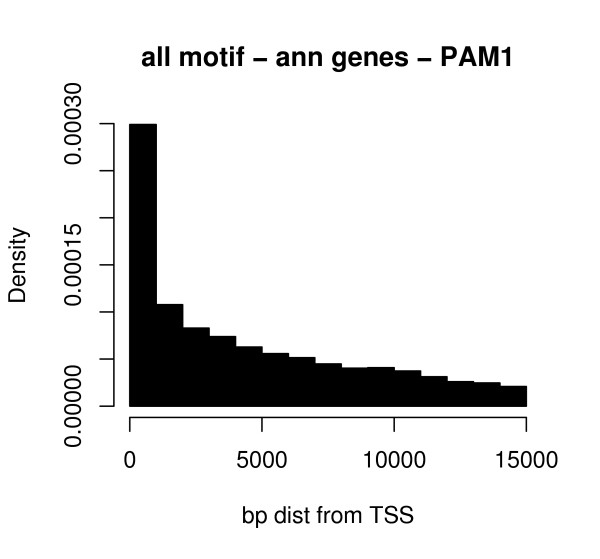
Histogram of the distance from the TSS of the motifs found significant by the algorithm (see text).